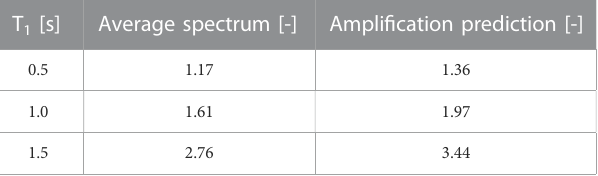
TABLE 5 Ampli fi cation of the spectral acceleration with respect to the design spectrum of soil class C for the computed fl oor response spectrum (average spectrum) and the ampli fi cation prediction according to Eq. 5 for the natural period of the subsystem (i.e., 2.07 s for non-structural wall of 2.4 m height). T 1 [s] Average spectrum [-] Ampli fi cation prediction [-] 0.5